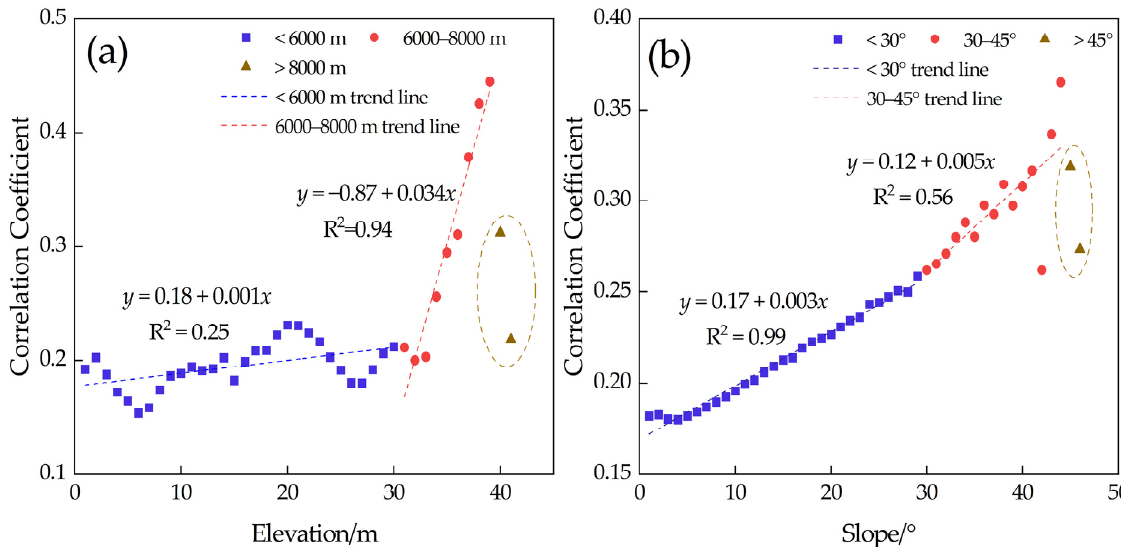
Figure 9. Correlation between NDVI and SPEI at different elevations and slopes: ( a ) elevation (1 indicates that the elevation is <200 m; 2 ‒ 40 represent the elevation zones of 200 ‒ 400 m, 400 ‒ 600 m, 600 ‒ 800 m, …, 8000 ‒ 8200 m, respectively; 41 denotes elevation of >8200 m); ( b ) slope (1 ‒ 45 represent slope zones of 0° ‒ 1°, 1° ‒ 2°, 2° ‒ 3°, …, 44° ‒ 45°, respectively; 46 denotes a slope > 45°).